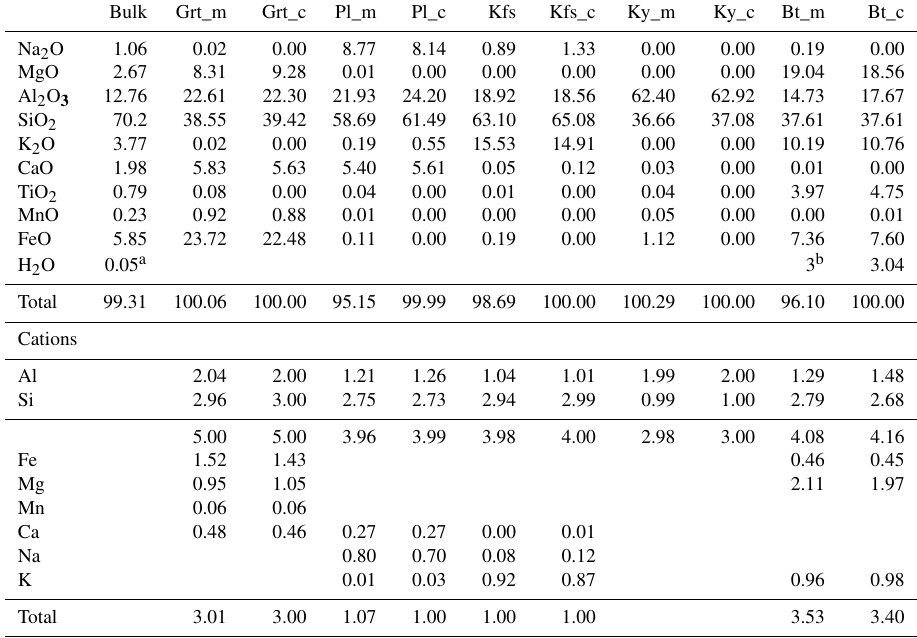
Table B1. Representative analysis for sample F68; m: measured; c: calculated from Perple_X at 1.2GPa and 690 ◦ C. Solution models: Omph(GHP), GlTrTsPg, melt(HP), Chl(HP), Sp(HP), Gt(GCT), Opx(HP), Mica(CHA1), Ctd(HP), St(HP), Bio(TCC), hCrd, Osm(HP), Carp(HP), Sud, feldspar, IlGkPy, Neph(FB),